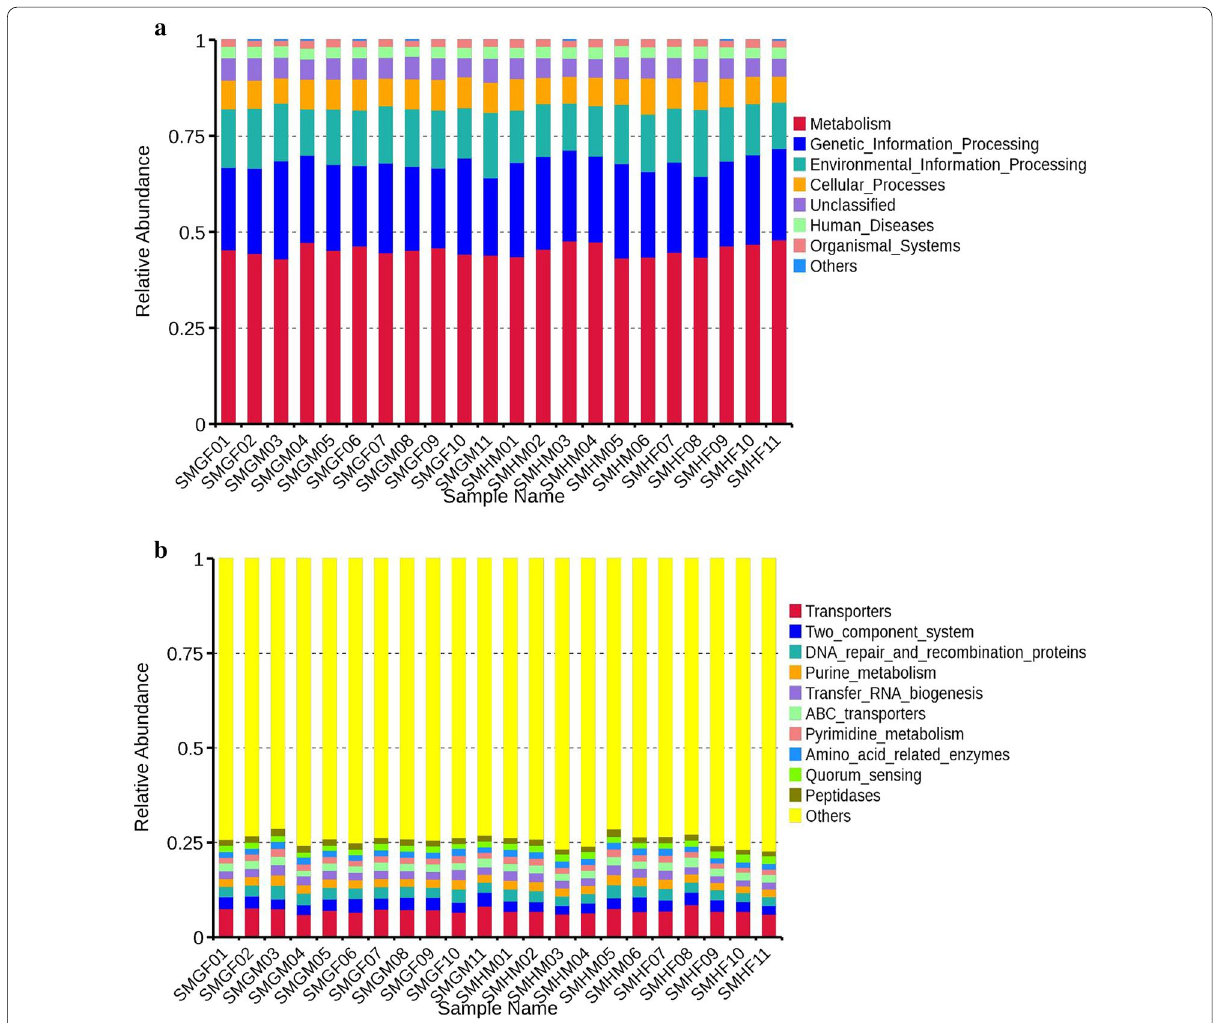
Fig. 6 Tax4Fun Function annotation histogram of relative abundance of level 1 ( a ) and level 3 ( b